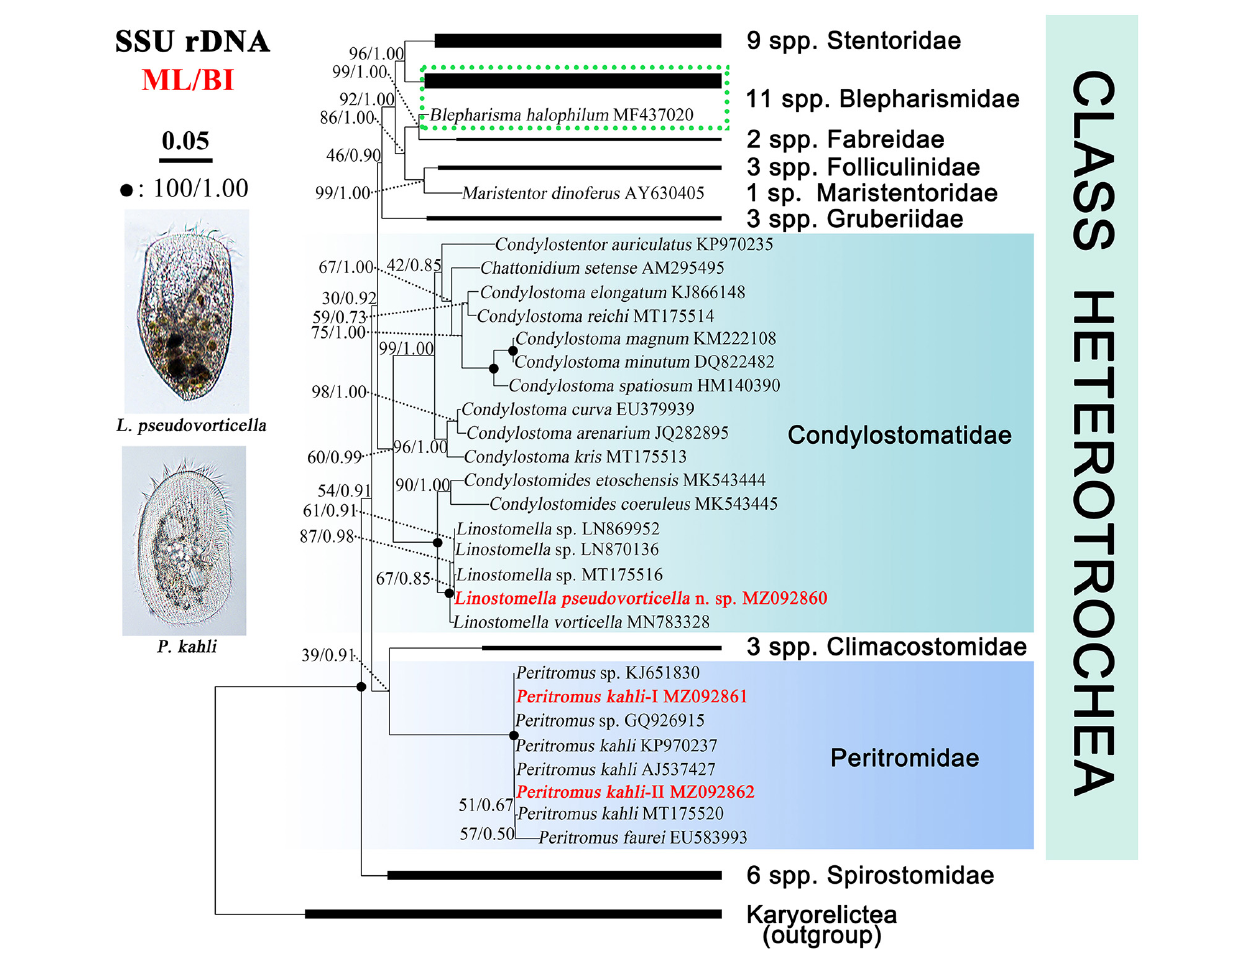
FIGURE 7 | Maximum likelihood (ML) tree inferred from SSU rDNA sequences showing positions of Linostomella pseudovorticella n. sp. and Peritromus kahli. Newly obtained sequences are in bold red font. Numbers near nodes represent non-parametric values of ML out of 1,000 replicates and Bayesian inference (BI) posterior probabilities. The scale bar corresponds to five substitutions per 100 nucleotide